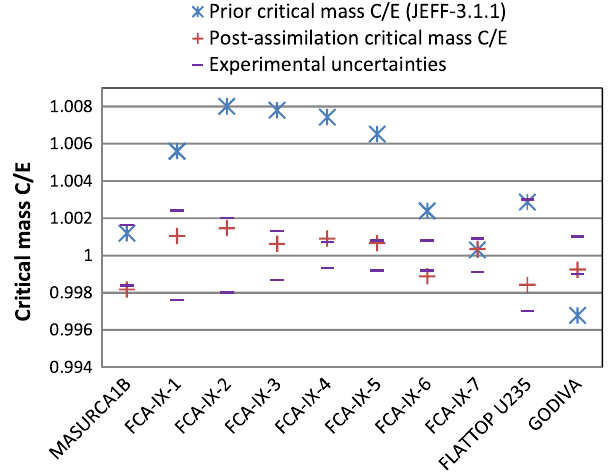
Fig. 4. Comparison between prior (JEFF-3.1.1) and posterior C/E values.